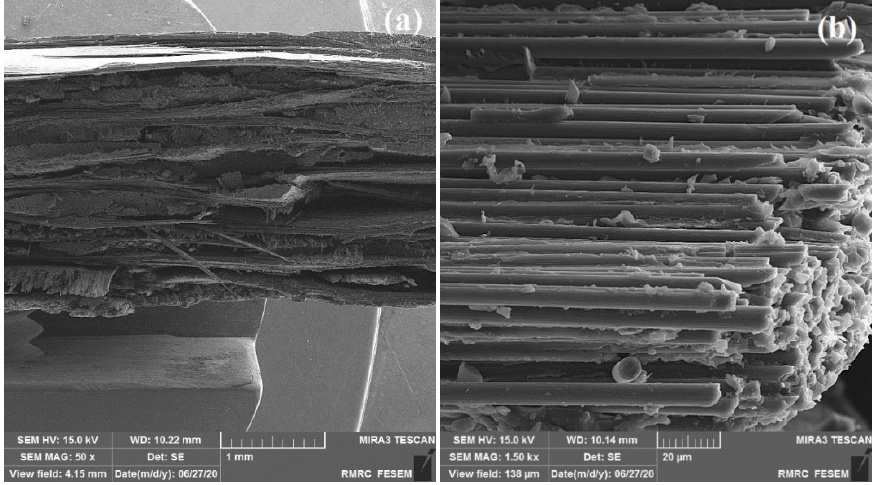
Figure 13. SEM micrographs of fracture surfaces of CFRP composites: ( a ) 50x and ( b ) 1.5 kx.